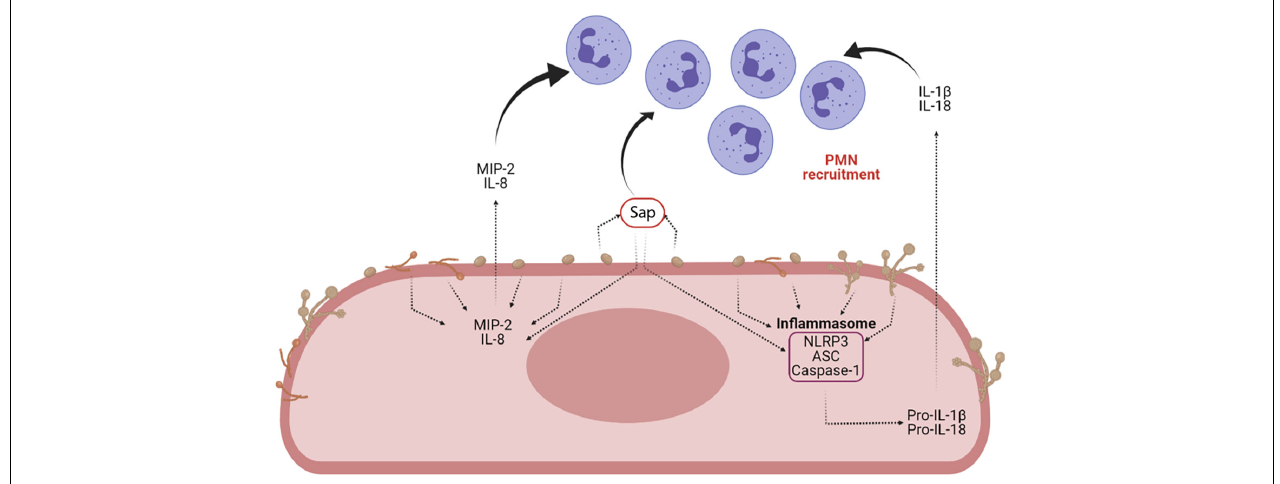
FIGURE 6 | Sap-induced inflammasome activation and inflammasome-dependent cytokine production. Sap secretion by C. albicans is one of the main virulence factors of the fungus. Sap can recruit neutrophils both directly and indirectly, through the activation of the NLRP3 inflammasome and the induction of proinflammatory cytokines (i.e., IL-1 β and IL-18) and chemokines (MIP-2 and IL-8) (Created with